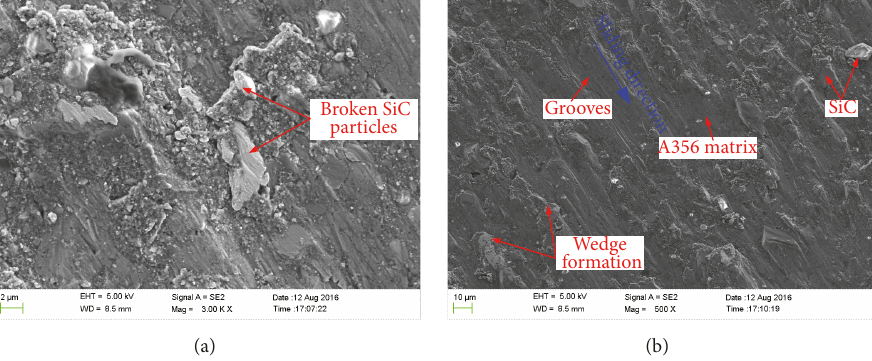
Figure 14: The surface topography of composites specimen for the test of 200 ∘ C ∼ 300 ∘ C: (a) 3000x and (b) 500x.